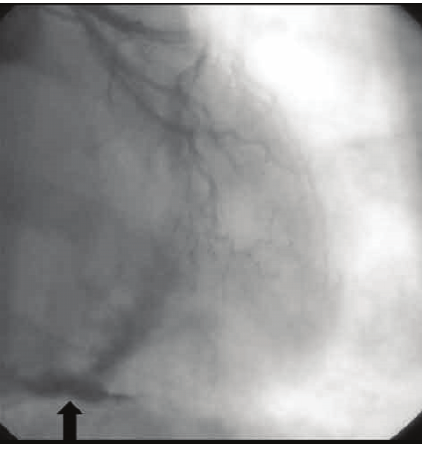
Figure4:Incoronaryangiographyduringfluoroscopylinearcalcifi- cations (thick arrow) around the heart.